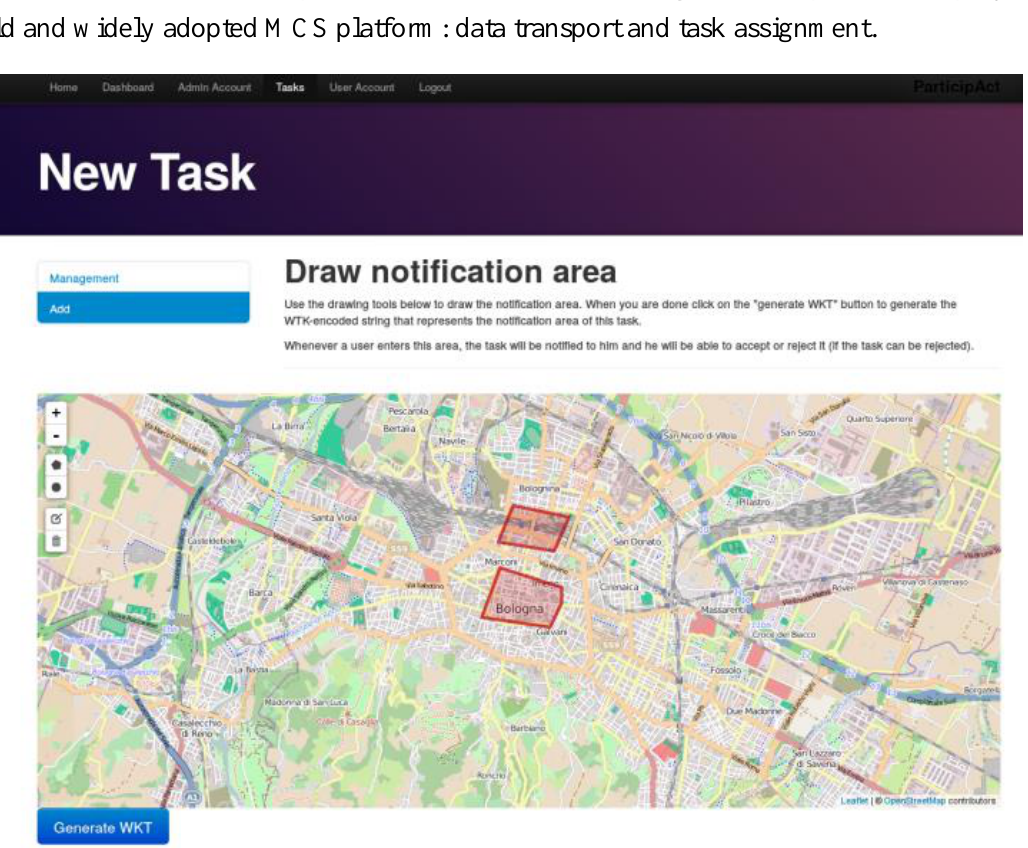
Figure 5. Screen capture of the ParticipAct Web Administration Interface. This figure shows the interactive page that allows to define the geo-notification area of a